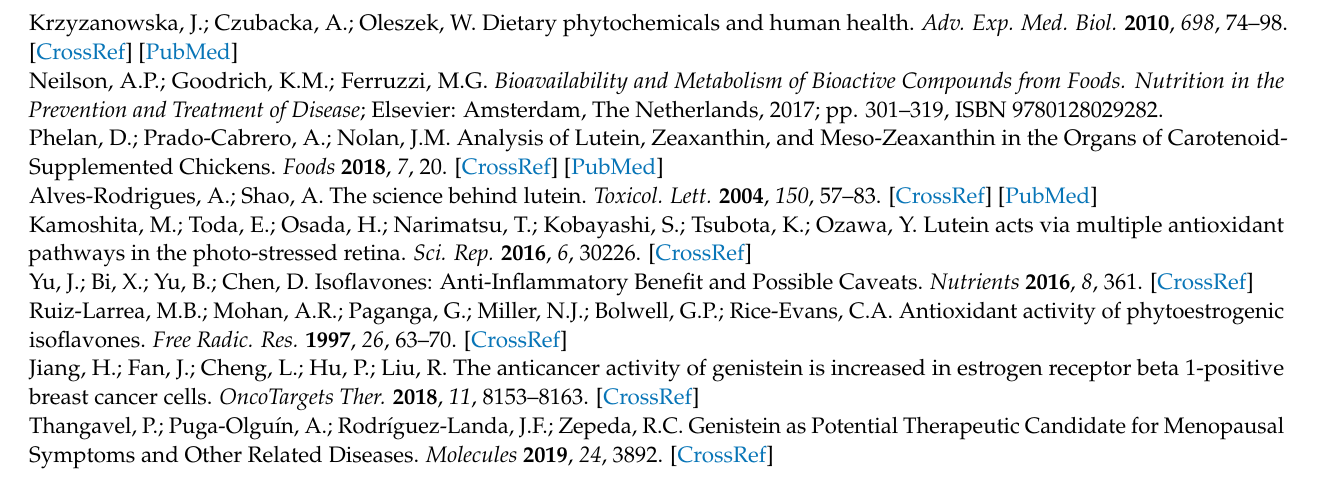
Table S7: Raw data of transport experiments of isoflavone formulations with bioenhancer extracts in differentiated CaCo-2 cells; Table S8: Raw data of metabolite concentrations in transport experiments of isoflavones with bioenhancer extracts in differentiated CaCo-2